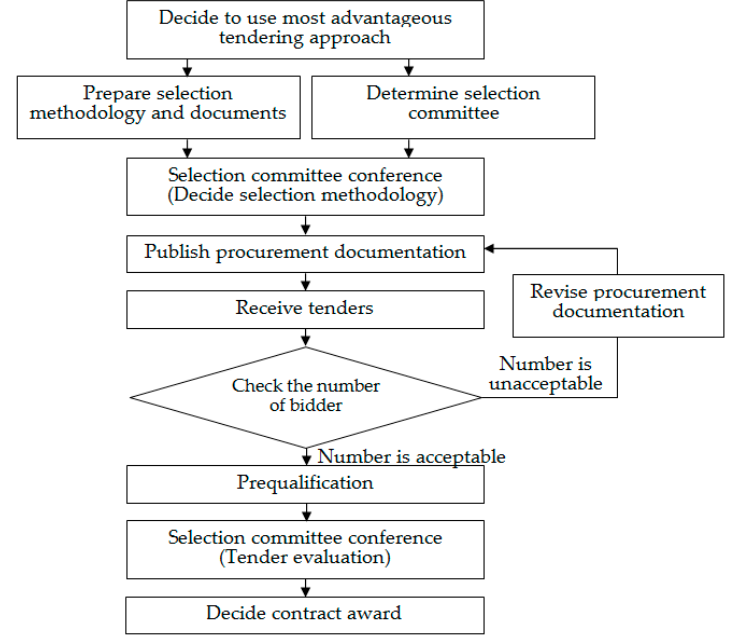
Figure 1. Contractor selection procedure [1].